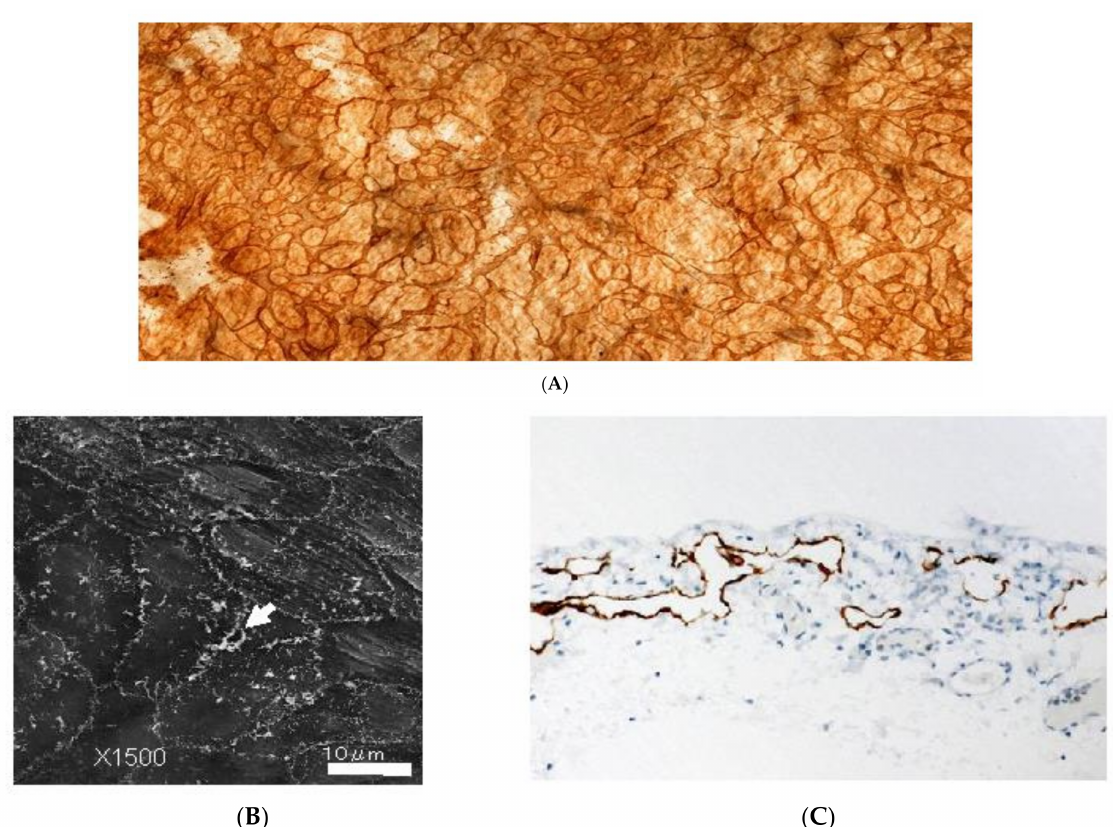
Figure 4. Lymphatic vessels in a falciform ligament. ( A ) (upper). Submesothelial lymphatic vessels in a falciform ligament (5 (cid:48) -Nase staining). ( B ) (lower left). Stomata on falciform ligament (arrow). ( C ) (lower right) Submesothelial lymphatic vessels in a falciform ligament (D2-40 immuno